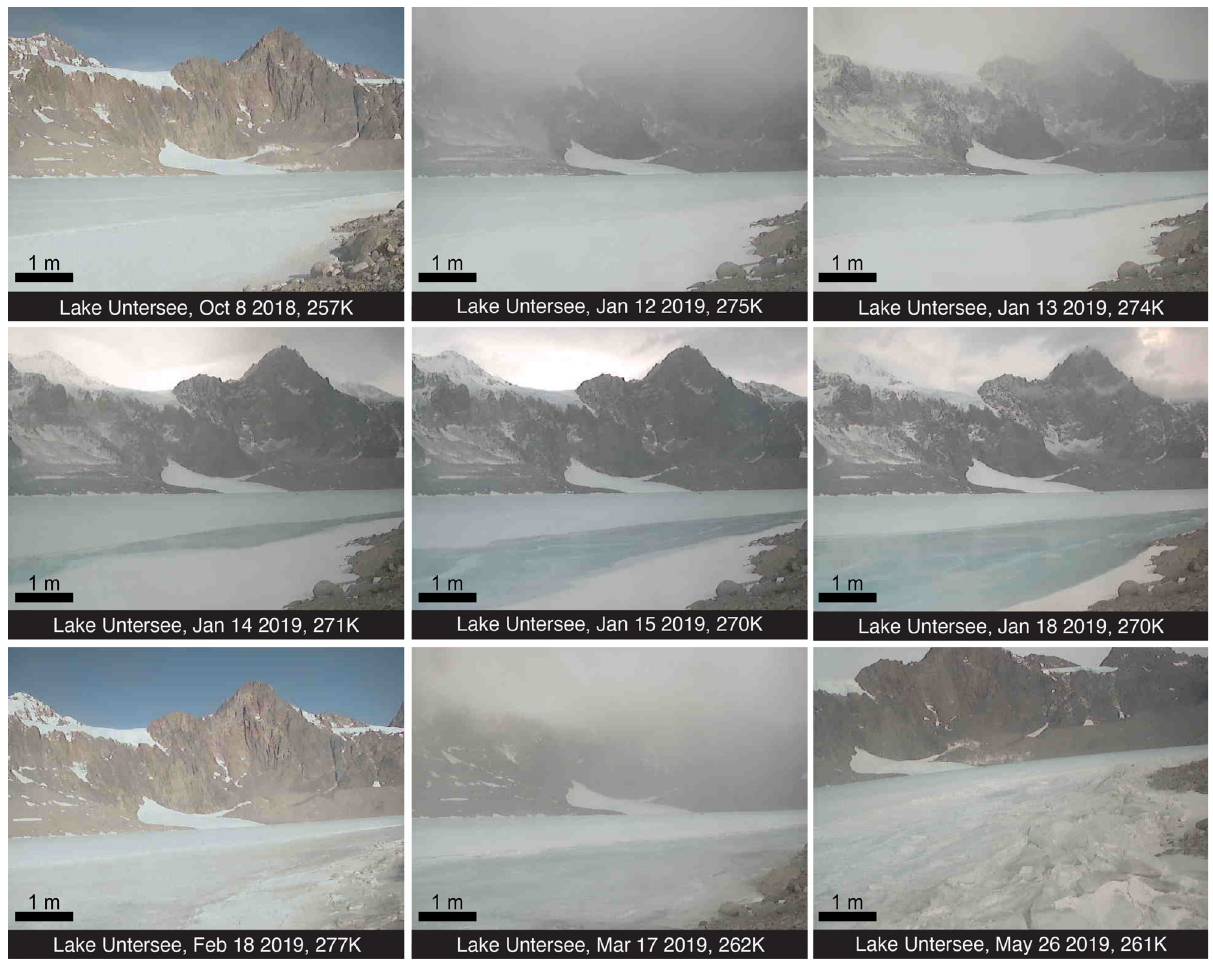
Fig. 4 Time-lapse photography of glacial lake outburst fl ood in Lake Untersee, Antarctica. Glacial lake outburst fl ood started on January 14th – 15th 2019, evidenced by the sudden release of water through the ice cover, which continued for many